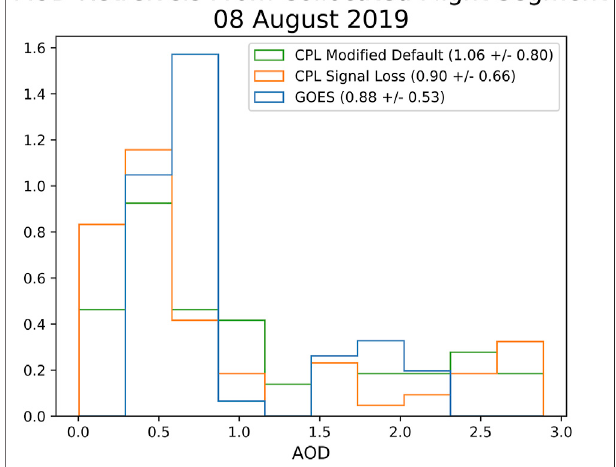
FIGURE 7 | Distributions of collocated retrievals of AOD values for the Williams Flats Fire from GOES (blue) and CPL signal loss technique (orange) and CPL modi fi ed default technique